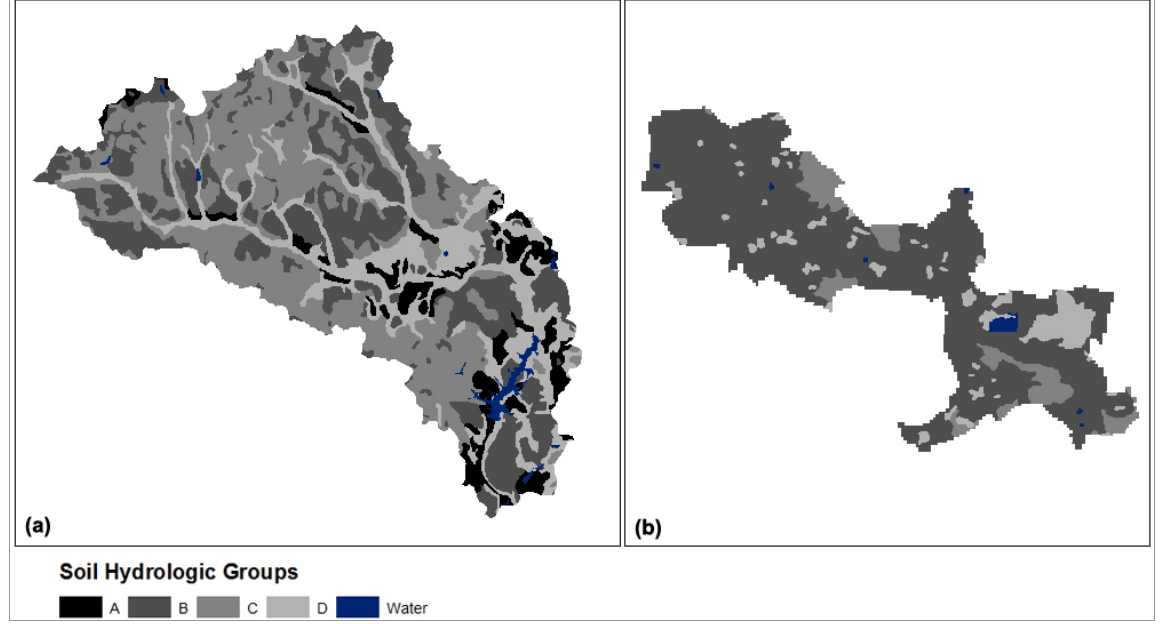
Figure 7. Area distribution of four hydrologic soil groups and water surface in Site 1 (Panther Creek watershed, The Woodlands green infrastructure development) and Site 2 (Bear Creek watershed, conventional